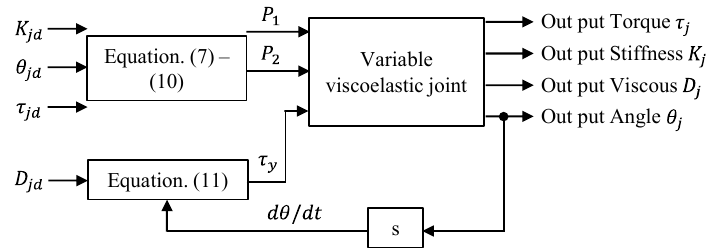
Figure 4. The block diagram of the feed-forward controller.